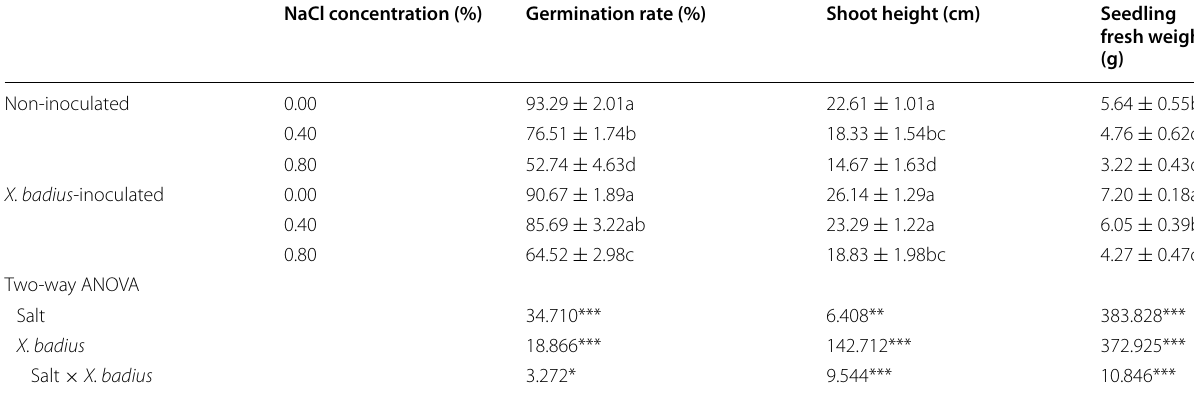
Data are presented as mean of at least six replicates standard deviation. Small letters in the same column show statistically significant differences among different ± PEG-induced drought stress treatments for the same parameter at P Table 4 Effect of X. badius inoculation on seed germination and seedling growth of L. multiflorum Lam. under different NaCl-induced salt